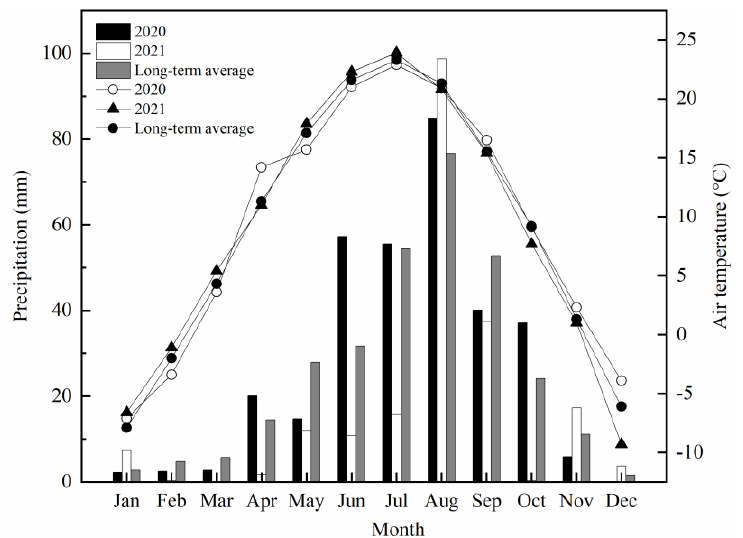
Figure 1. Monthly precipitation and mean temperature during the experimental period in 2020 and 2021 and long-term average (2000 – 2020) at the Yanchi county, Ningxia, China. Note: Temperature = bar chart, precipitation = dot chart.